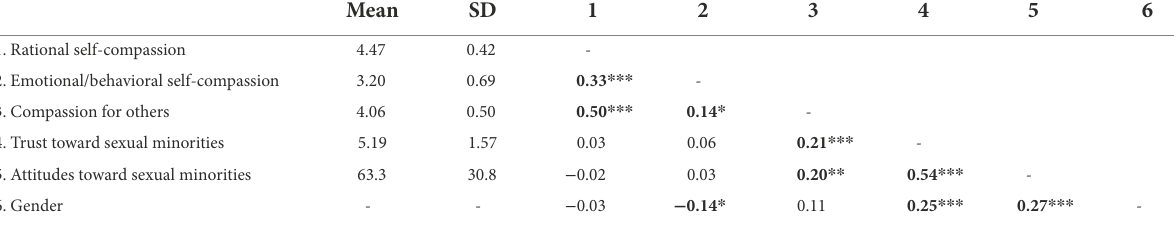
TABLE 1 Descriptive statistics and correlations between the study